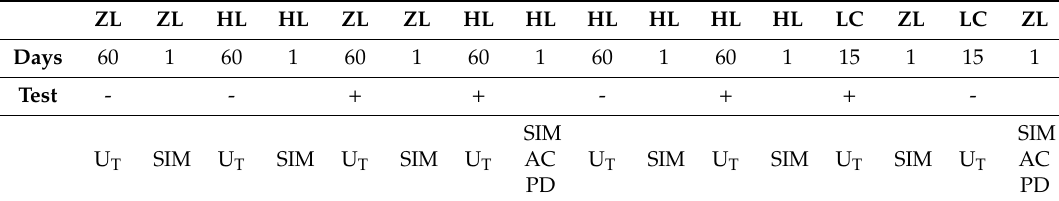
Table 3. Prototype installation test procedure of HVDC GIS system [61].